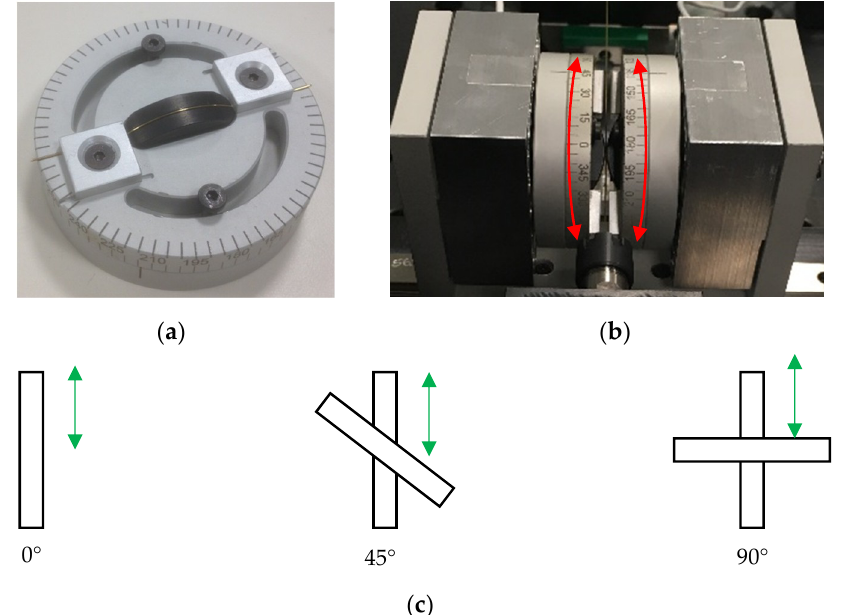
Figure 7. Developed wire fixation system that allows different crossing angles (0–90°). ( a ) Top view of the fixation system; ( b ) detail of the contact zone to locate the desired crossing angle; ( c ) different crossing angles.